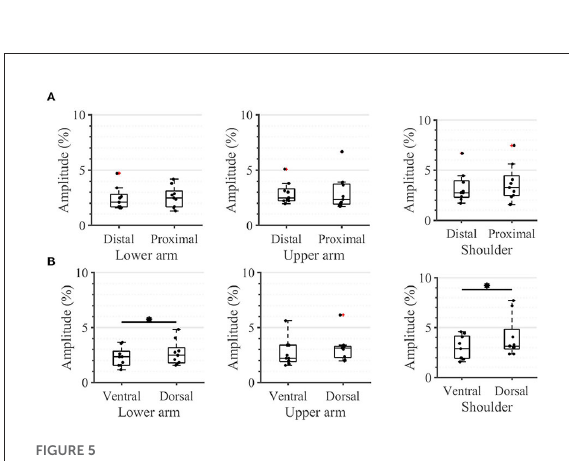
FIGURE5 Task 1-Sensation thresholds. A closer look (in percent of the maximum stimulation amplitude) for (A) the distal and proximal parts of the three segments of the arm, (B) the ventral and dorsal parts of the three segments of the arm. The box plots depict the median value (horizontal line) and the IQR (rectangle) of mean ST data collected from 10 subjects. Red crosses indicate statistical outliers within a single box plot ( n = 10). An asterisk indicates a significant statistical difference ( p < 0.05).